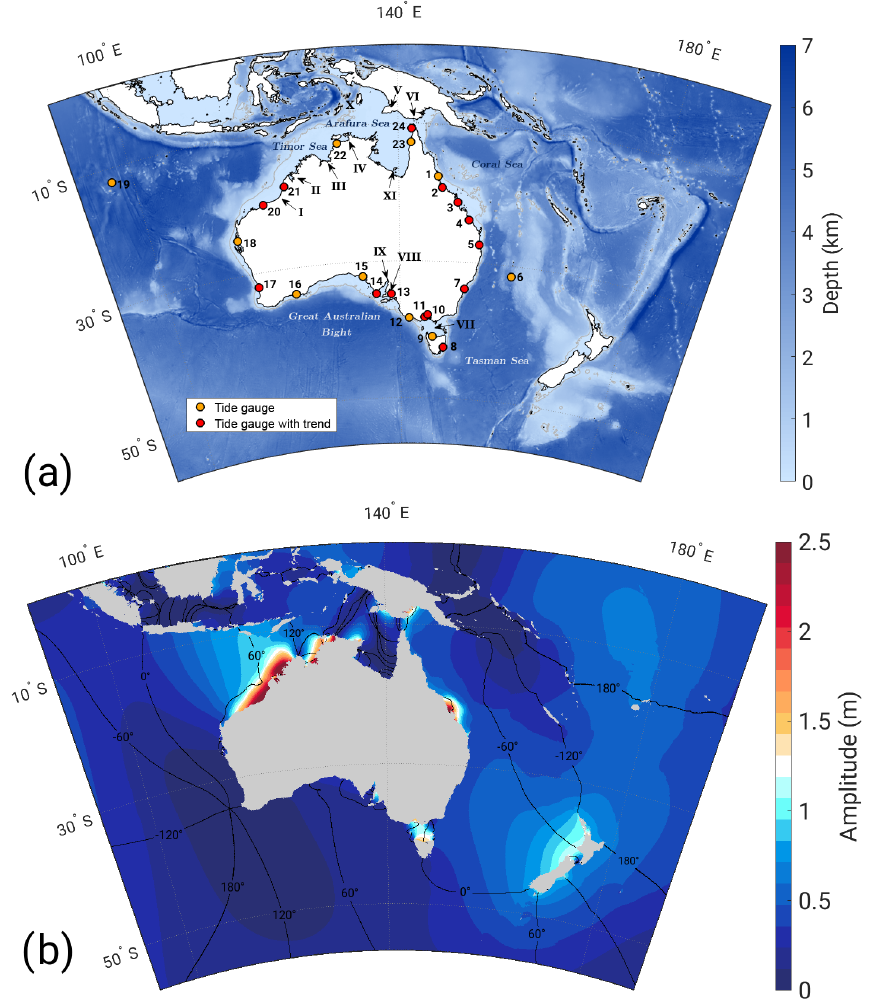
Figure 1. (a) Bathymetry of the model domain and tide gauge sites used in the analysis (coloured dots): see Table 1. Locations at which M 2 trends were estimated are shown in red. Regions mentioned in subsequent sections of the paper are marked on the map: I – Eighty Mile Beach, II – King Sound, III – Joseph Bonaparte Gulf, IV – Van Diemen Gulf, V – Yos Sudarso Island, VI – Torres Strait, VII – Bass Strait, VIII – Gulf St. Vincent, IX – Spencer Gulf, X – Arafura Islands, XI – Wellesley Islands. (b) Co-tidal chart of the M 2 constituent amplitude for the control simulation. Black lines represent co-phase lines with 60 ◦